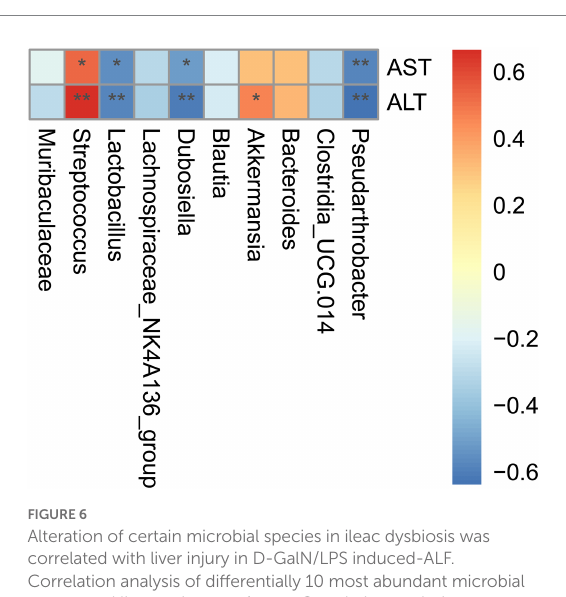
FIGURE 6 Alteration of certain microbial species in ileac dysbiosis was correlated with liver injury in D-GalN/LPS induced-ALF. Correlation analysis of differentially 10 most abundant microbial genera and liver aminotransferase. Correlation analysis was conducted by the Spearman rank correlation test, and red (positive correlation) and blue (negative correlation) colors represent different correlation coefficients. * p < 0.05; ** p < 0.01; *** p < 0.001 and **** p < 0.0001 for the comparison. Veh, Vehicle (saline control); VeAL, Vehicle + D-GalN/LPS; IAAL, IAA + D-GalN/ LPS. n = 10 in each